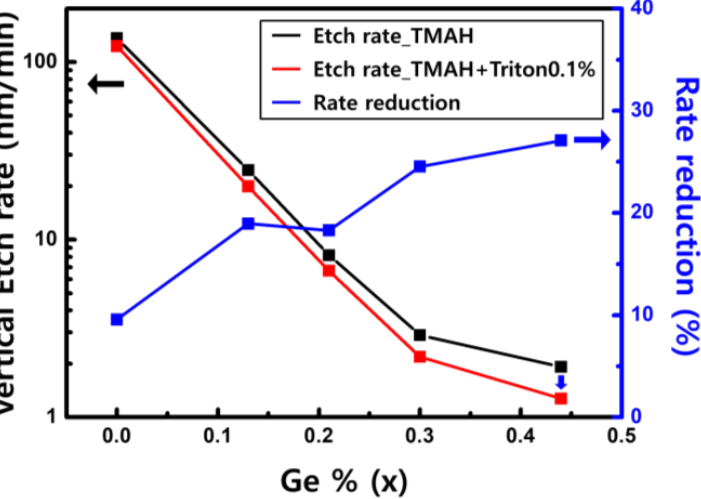
Figure 6. Vertical etch rates of Si and Si 1 − x Ge x in 25 wt% TMAH with and without 0.1 vol% Triton.